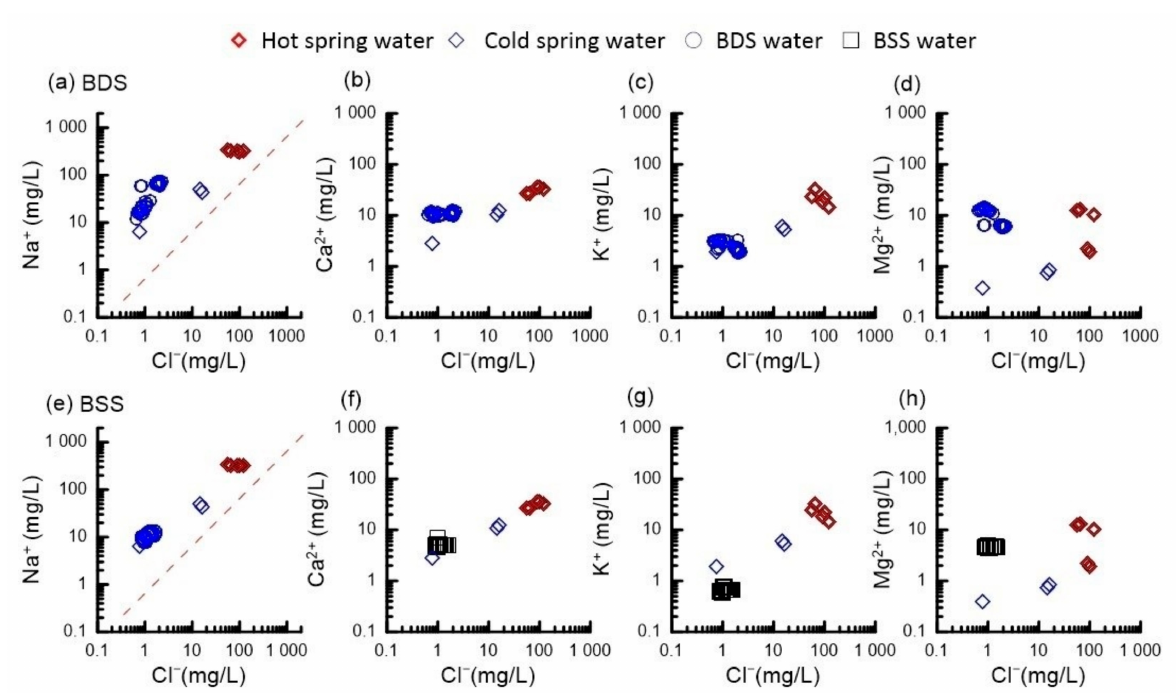
Figure 5. Relationship between Cl − and Na + ( a , e ), Ca 2+ ( b , f ), K + ( c , g ), and Mg 2+ ( d , h ) in the BDS ( a – d ) and BSS ( e – h ) bottled waters, respectively. The red dotted line at ( a , e ) is Seawater Dilution Line (SWDL). Except for Mg 2+ , the chemical components of the BSS bottled waters seems to indicate that they have closer relationship with the hot spring waters in the Mt. Baekdu